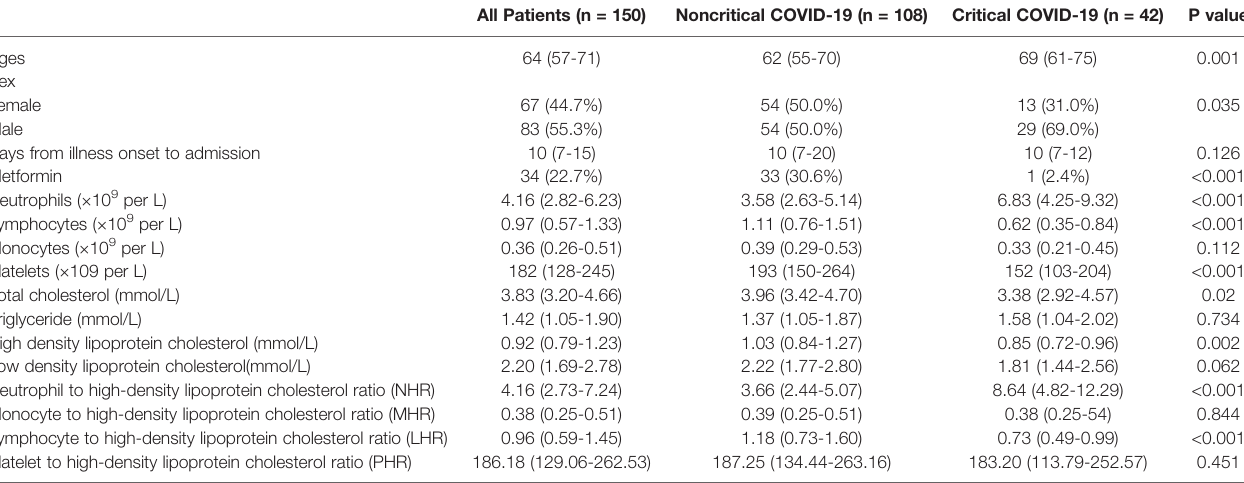
TABLE 5 | Baseline characteristics of diabetic patients with COVID-19 on admission to hospital.